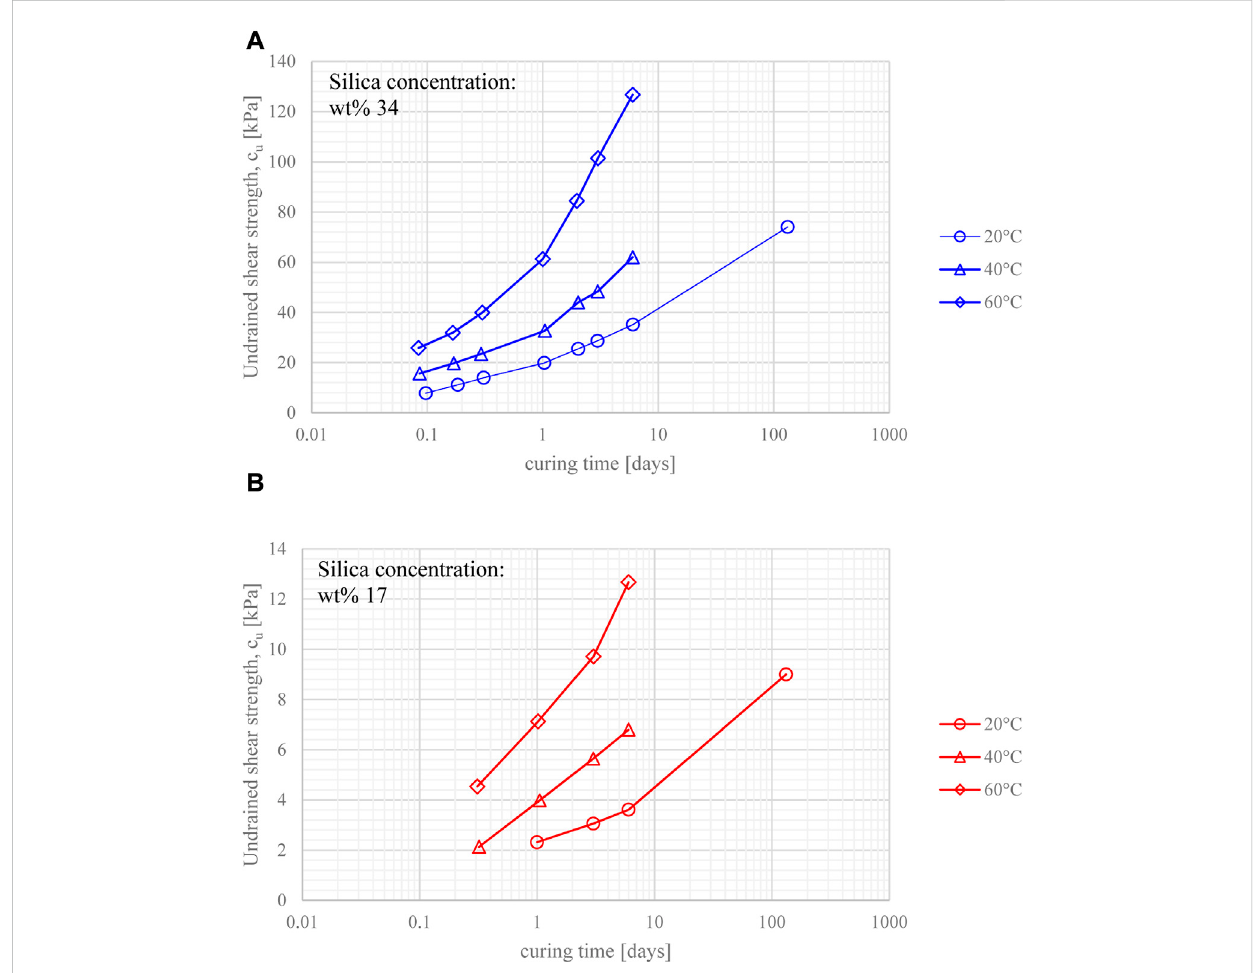
FIGURE 6 Undrainedshearstrengthevolutionagainstcuringtimeforgelsamplescuredatdifferenttemperatures,atsilicaconcentration (A) wt%34,and (B) wt %